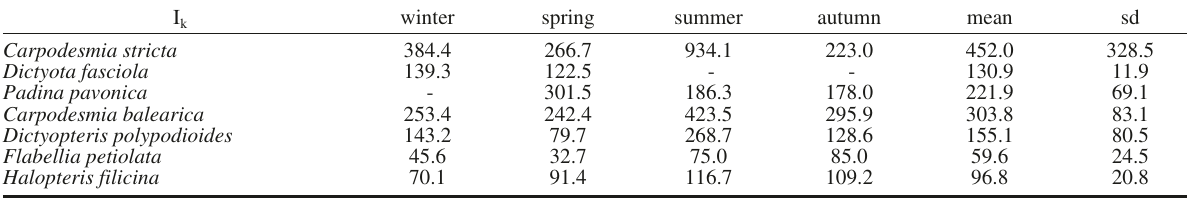
, in μmol photon m –2 s –1 ) for species and season. k